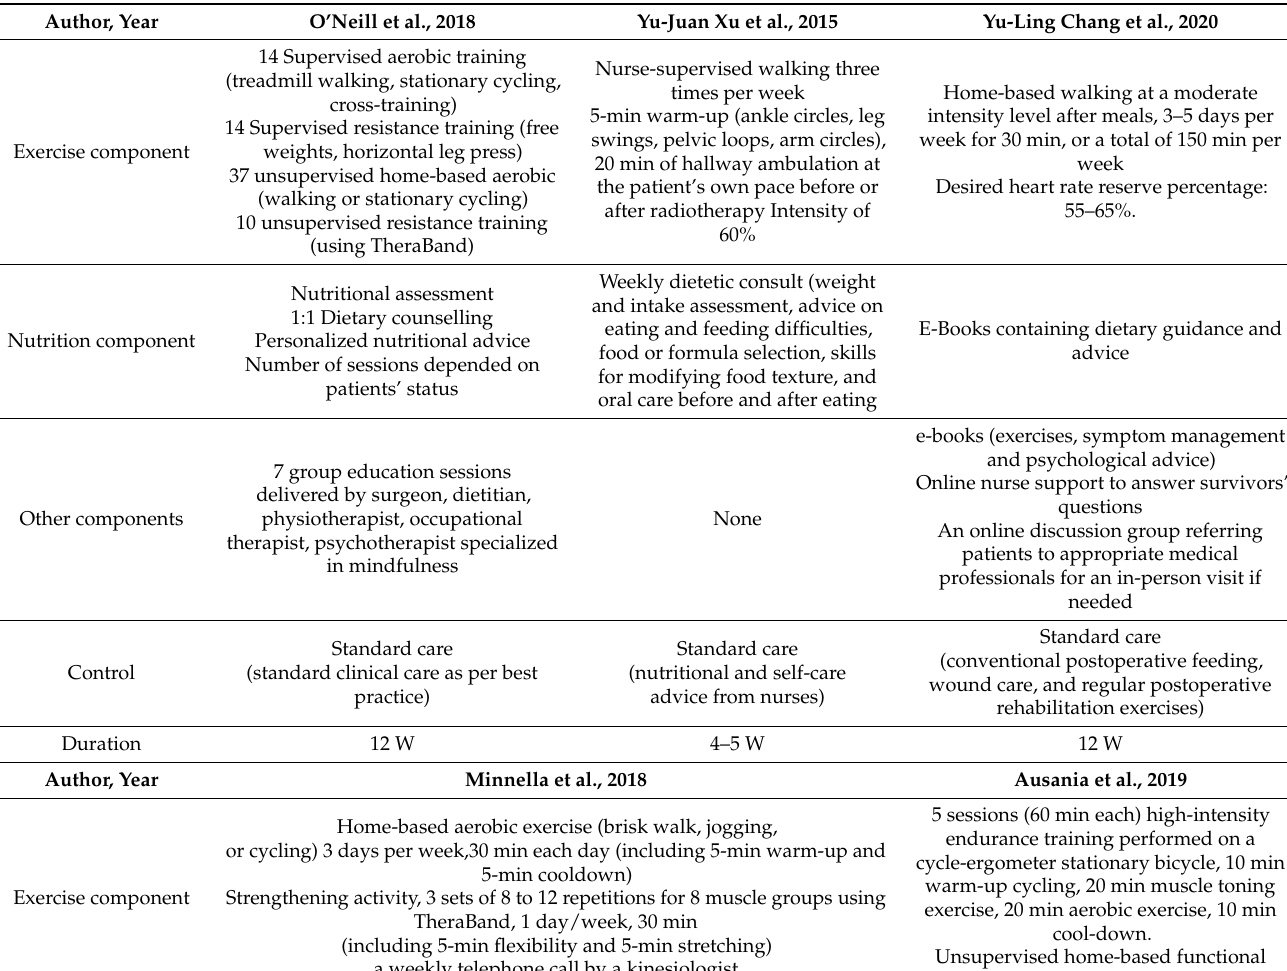
Table 2. Description of interventions in included